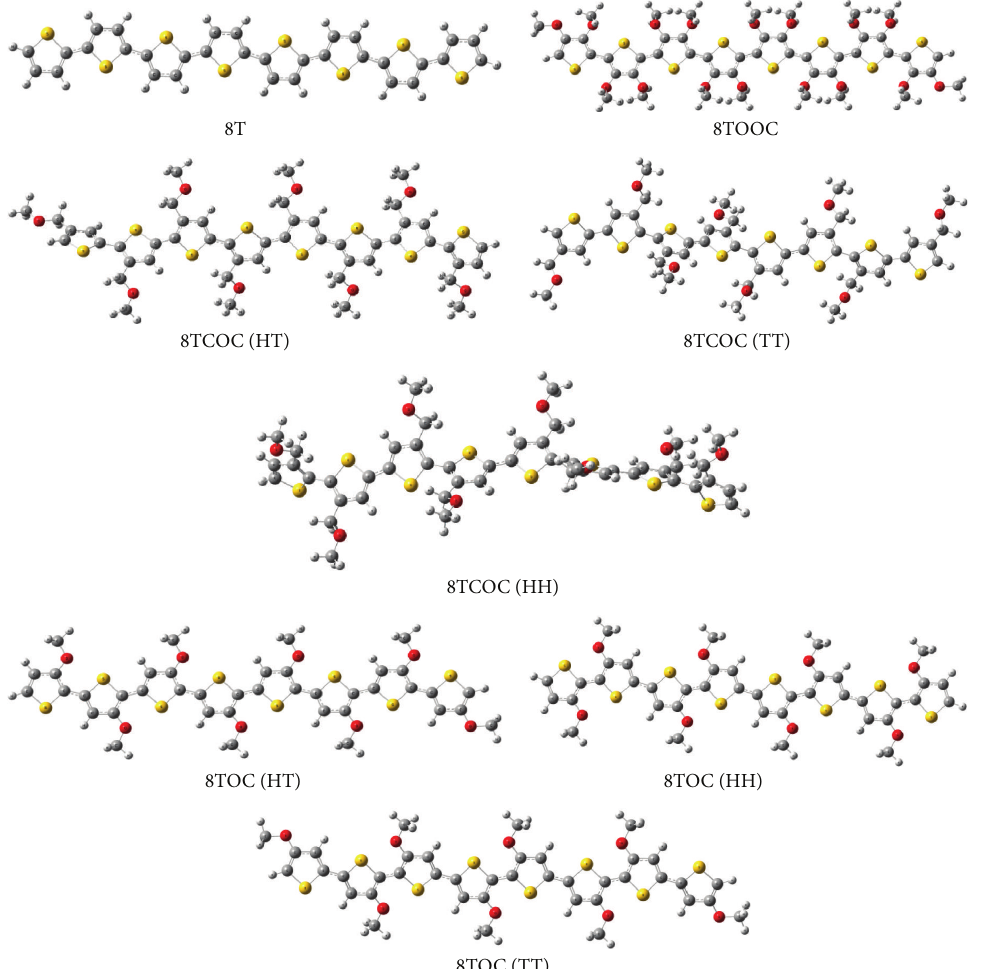
Figure 4: Optimized structures of the studied